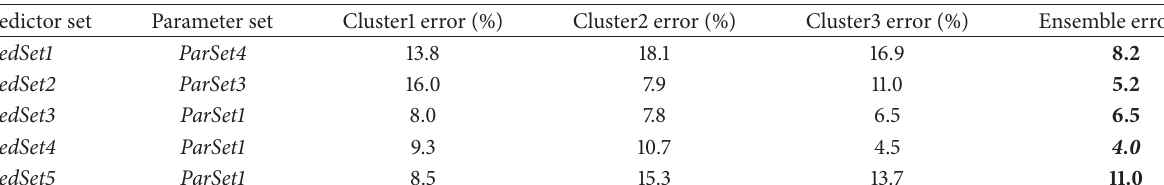
Table 6: Mean absolute errors (%) for annual Indian summer monsoon rainfall prediction by individual MLP cluster models and ensemble model for test period 2001–2013. Reports minimum error of 4.0 %.